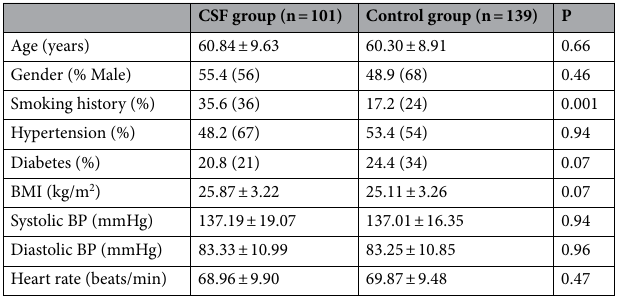
Table 1. Comparison of clinical characteristics between CSF group and control group. Values shown are means ± SD or percentages. CSF coronary slow flow, BMI Body mass index.